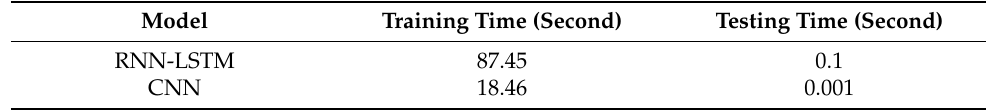
Table 4. Training time of RNN-LSTM and